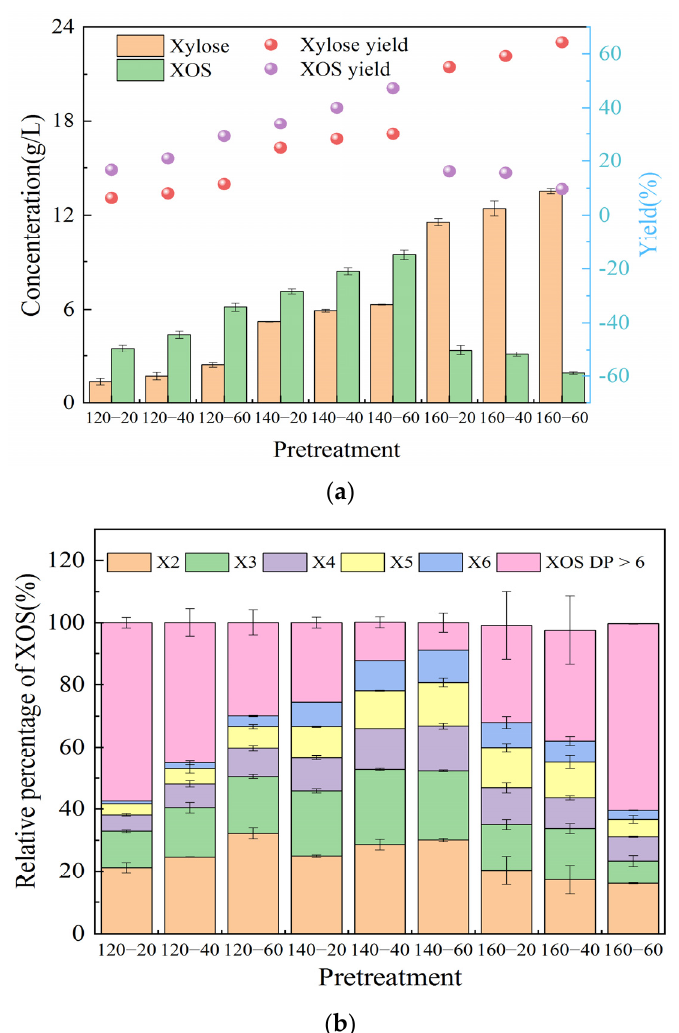
Figure 1. Xylose and XOS yields at different pretreatment ( a ) relative percentages of XOS at different pretreatment ( b ) in VR.